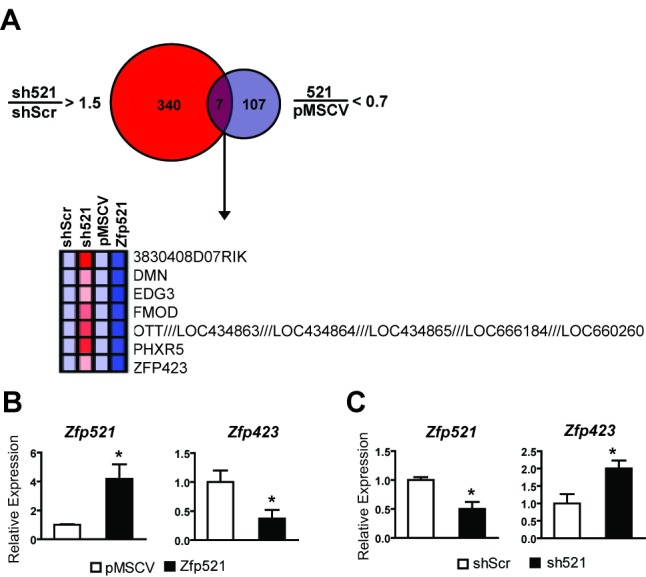
Zfp521 suppresses Zfp423 expression.(A) 3T3-L1 preadipocytes were transduced with retrovirus expressing sh521, shScr, Zfp521, or empty vector. After puromycin selection, RNA was collected and submitted for analysis using Affymetrix arrays. The Venn diagram shows the number of genes up-regulated by sh521 (sh521/shScr>1.5-fold) and down-regulated by Zfp521 (Zfp521/pMSCV<0.7-fold). The heat map corresponds to genes in the intersecting set. (B) Overexpression of Zfp521 in C3H10T1/2 cells represses Zfp423 expression by Q-PCR. (C) Knockdown of Zfp521 in C3H10T1/2 cells enhances Zfp423 expression by Q-PCR. Data presented as mean ± SD, n = 3, *p<0.05.